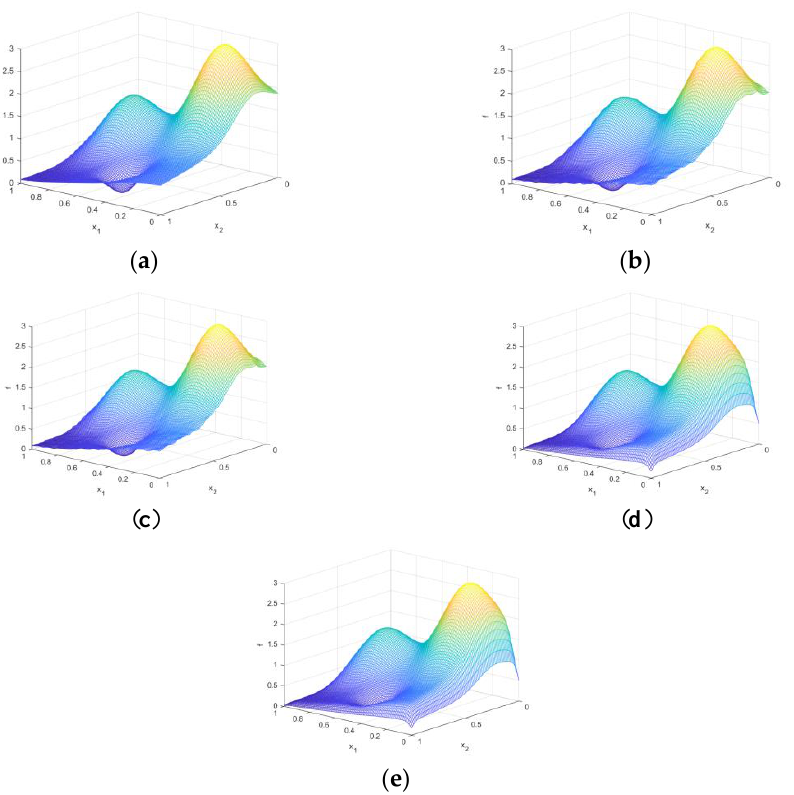
Figure 4. Sketches of Franke function. ( a ) True density function. ( b ) AMQIDE. ( c ) MQIDE. ( d ) MKDE. ( e ) MBKDE.